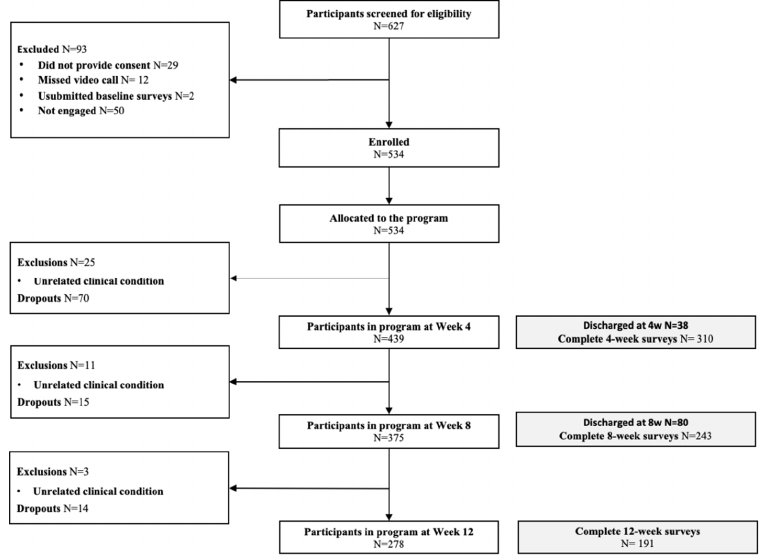
Figure 2. Study flow chart following CONSORT guidelines. Table 1. Baseline characteristics of study participants (N =